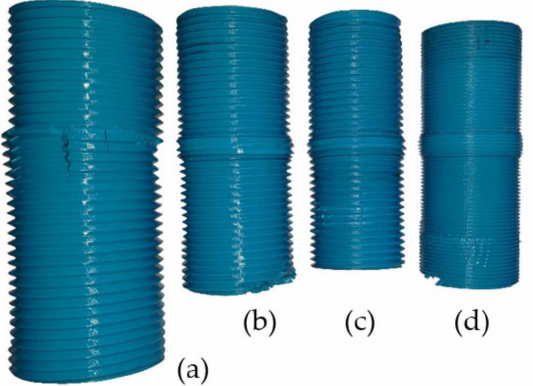
Figure 7. The view of selected damaged threaded rods; ( a ) fracture failure, ( b – d ) ductile failure; damage in the initial and final sections of rods ( b ) and ( d ) were made after the tests to assess the quality of the internal structure (they are not the result of the